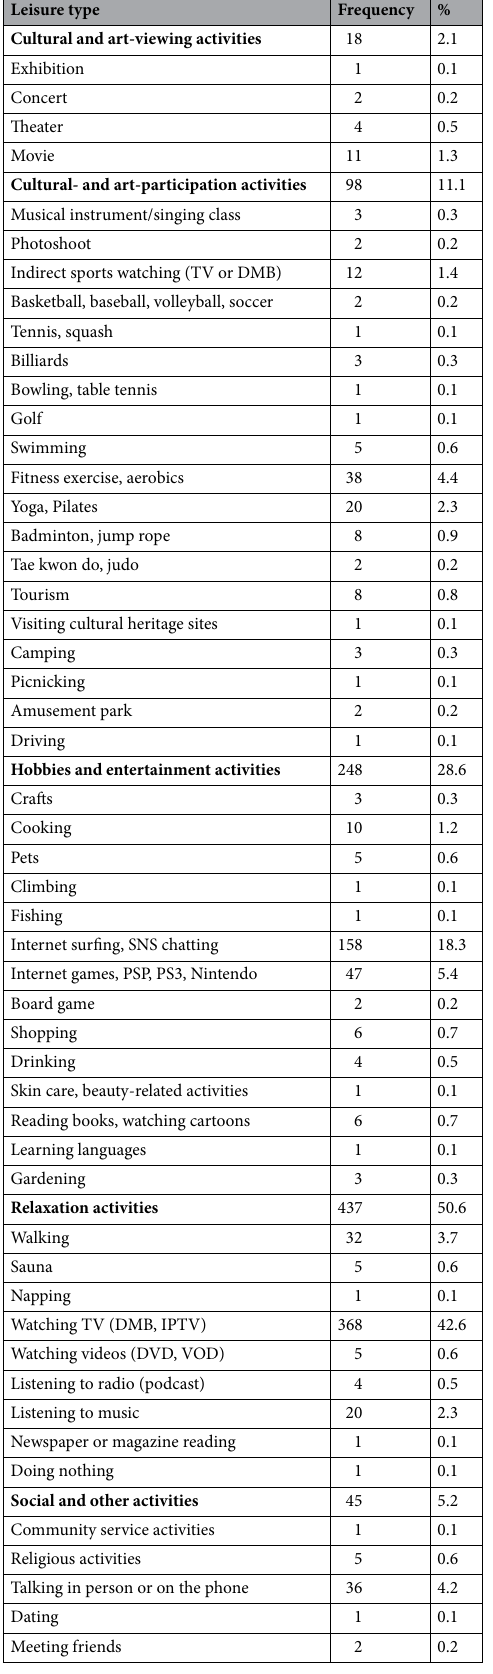
Table 1. Leisure types by participants. Selected by allowing